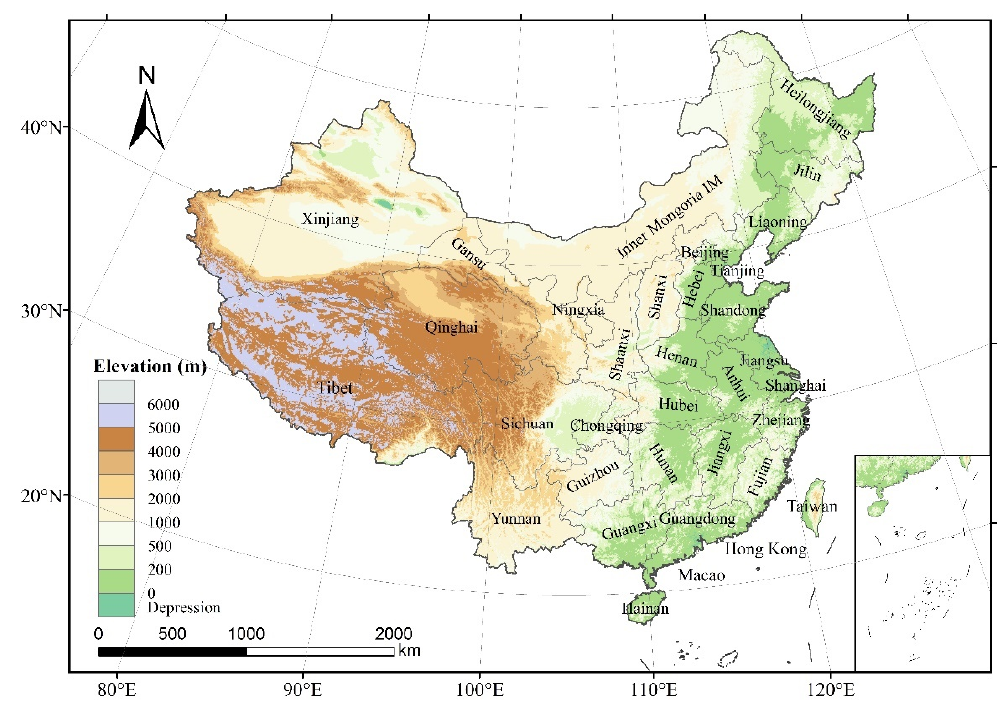
Figure 1. Geographical locations and topography of China.